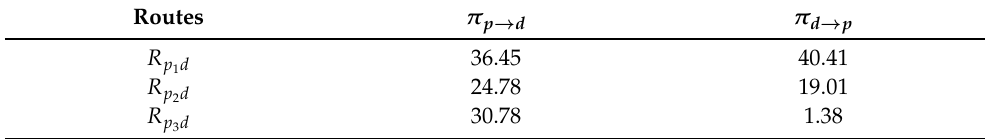
Table 5. The utilities estimated for passengers and driver through the joint route R pd